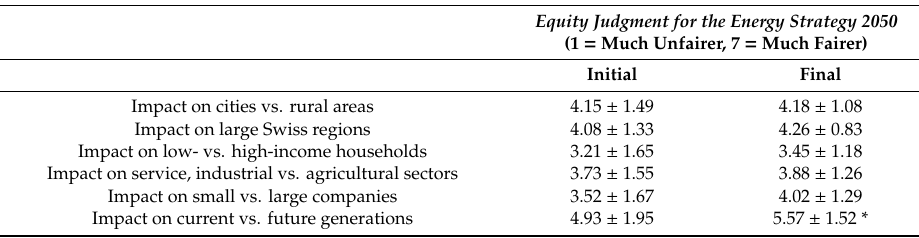
Table 4. Initial and final equity judgments for the Energy Strategy 2050 (means ± standard deviations).